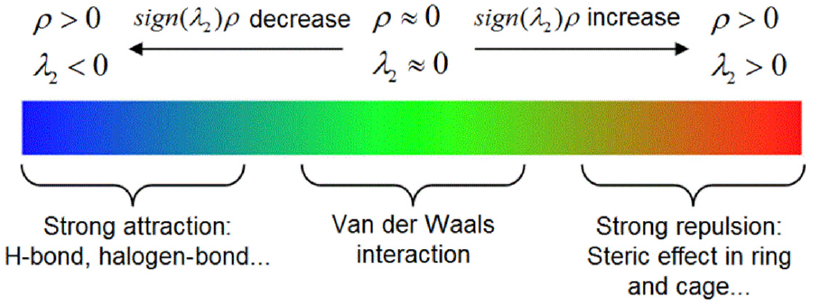
Figure 4. Color-coded legend explaining the significance of sign ( λ 2 ) ρ to help interpret the scatter